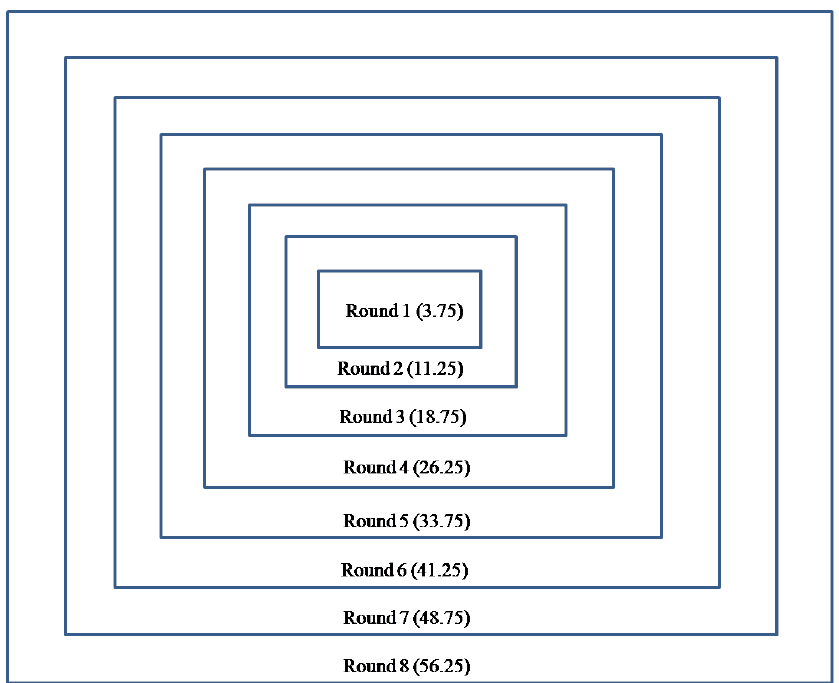
Figure 4. Arrangement of different rounds throughout the defined aperture